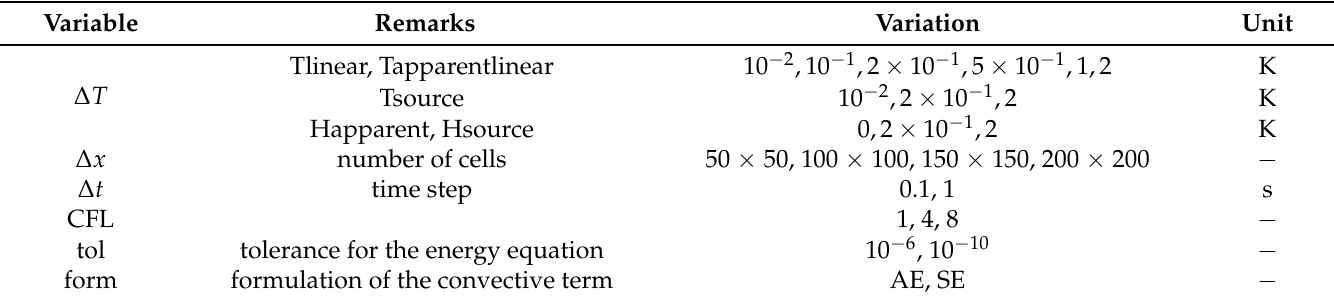
Table 2. Overview of the varied